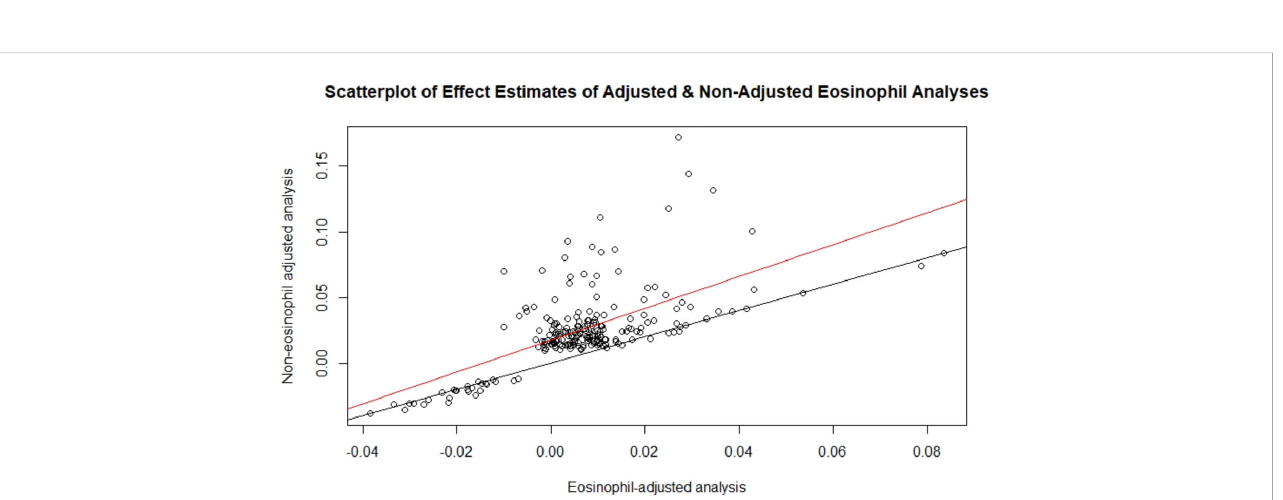
FIGURE 3 Scatterplot of effect estimates of adjusted and non-adjusted eosinophil analyses. Effect estimates of the 216 FDR-signi fi cant genes from the non- eosinophil adjusted analysis plotted against those of the corresponding genes in the eosinophil adjusted analysis. The line of best fi t is in red and the y=x line is in